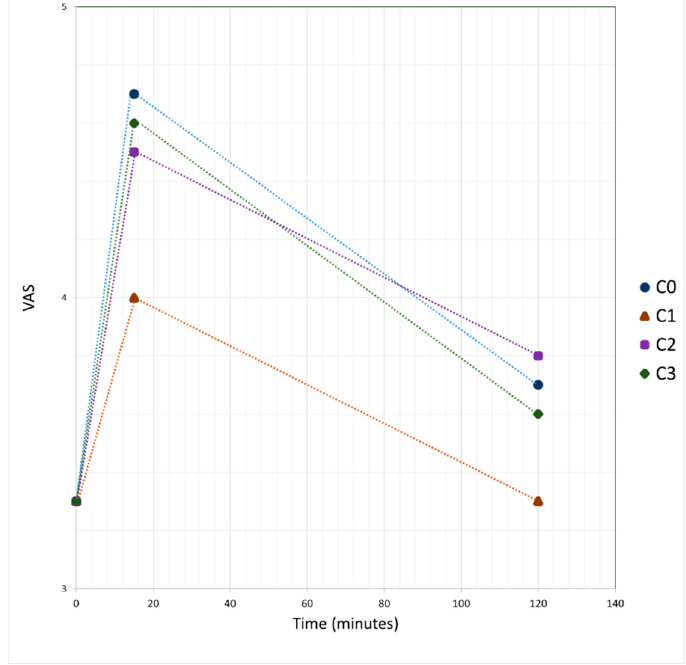
Figure 2. Satiation and satiety rating through time, before intake and after 15 and 120 min of intake of cupcake samples.